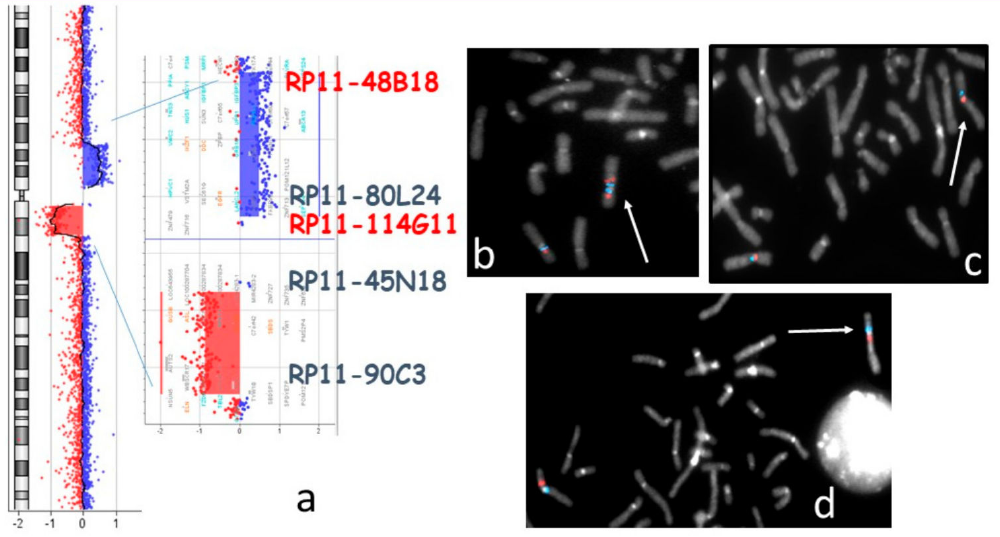
Figure 1. ( a ) Proband’s array-CGH profile of chromosome 7 with enlargement of the regions involved in Copy Number Variants (CNVs). The localization of the probes used for FISH experiments is indicated. ( b , c ) Bacterial Artificial Chromosome (BAC) FISH analysis of the proband’s metaphases: ( b ) RP11-48B18 (red), RP11-80L24 (blue). The white arrow points to the duplicated signals and inverted orientation on 7q of the two 7p probes: ( c ) RP11-114G11 (red), RP11-45N18 (blue). The white arrow indicates the inverted orientation of the pericentromeric region on the rearranged chromosome 7; ( d ) BAC FISH on the proband’s mother’s metaphases: 48B18 (red), RP11-90C3 (blue). The white arrow points to chromosome 7 with pericentric